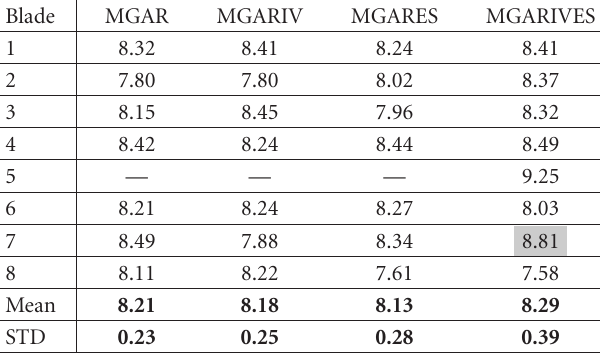
Table 6: 2EO and 8EO case: the second blade mode frequencies (in Hz) recovered by BTT